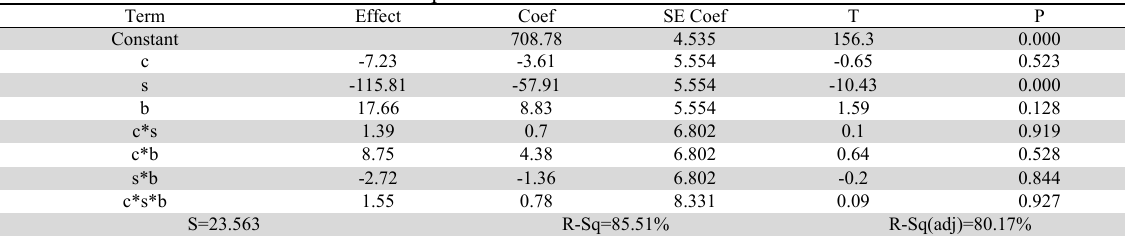
Estimated effects and coefficients for the total profit Term